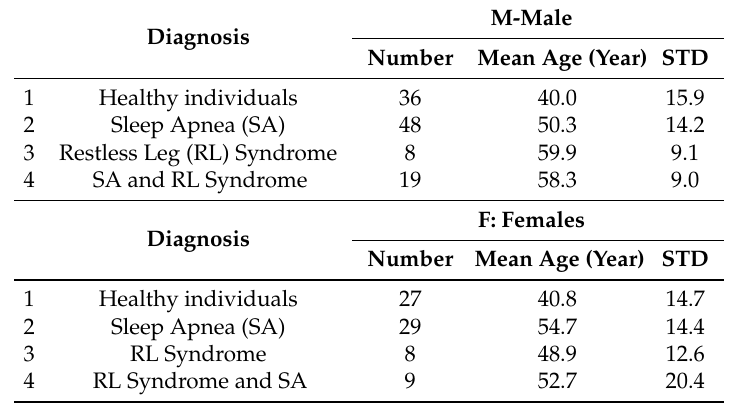
Table 1. Specification of the set of 184 individuals under study (M: number of males, F: number of females) with their age distribution, including (i) healthy individuals; (ii) individuals with sleep apnea (SA); (iii) individuals with the restless leg (RL) syndrome; and (iv) individuals with RL syndrome and